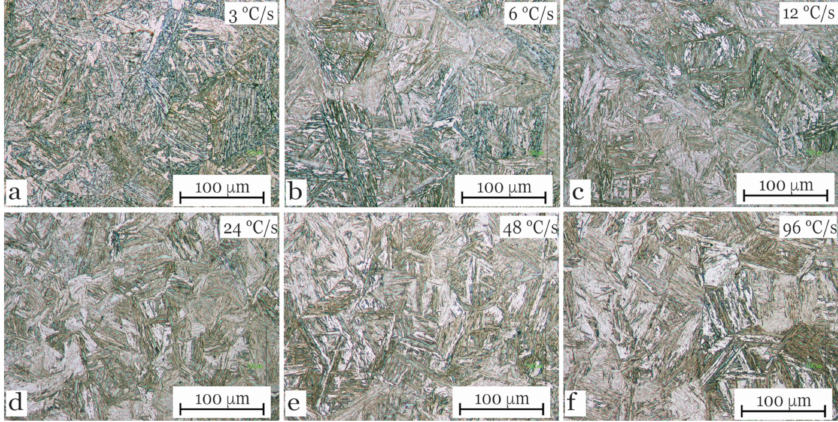
Figure 4. Microstructures of DQ steel after CCT tests in the Gleeble simulator, no deformation. Cooling rates 3–96 ◦ C / s ( a – f ).